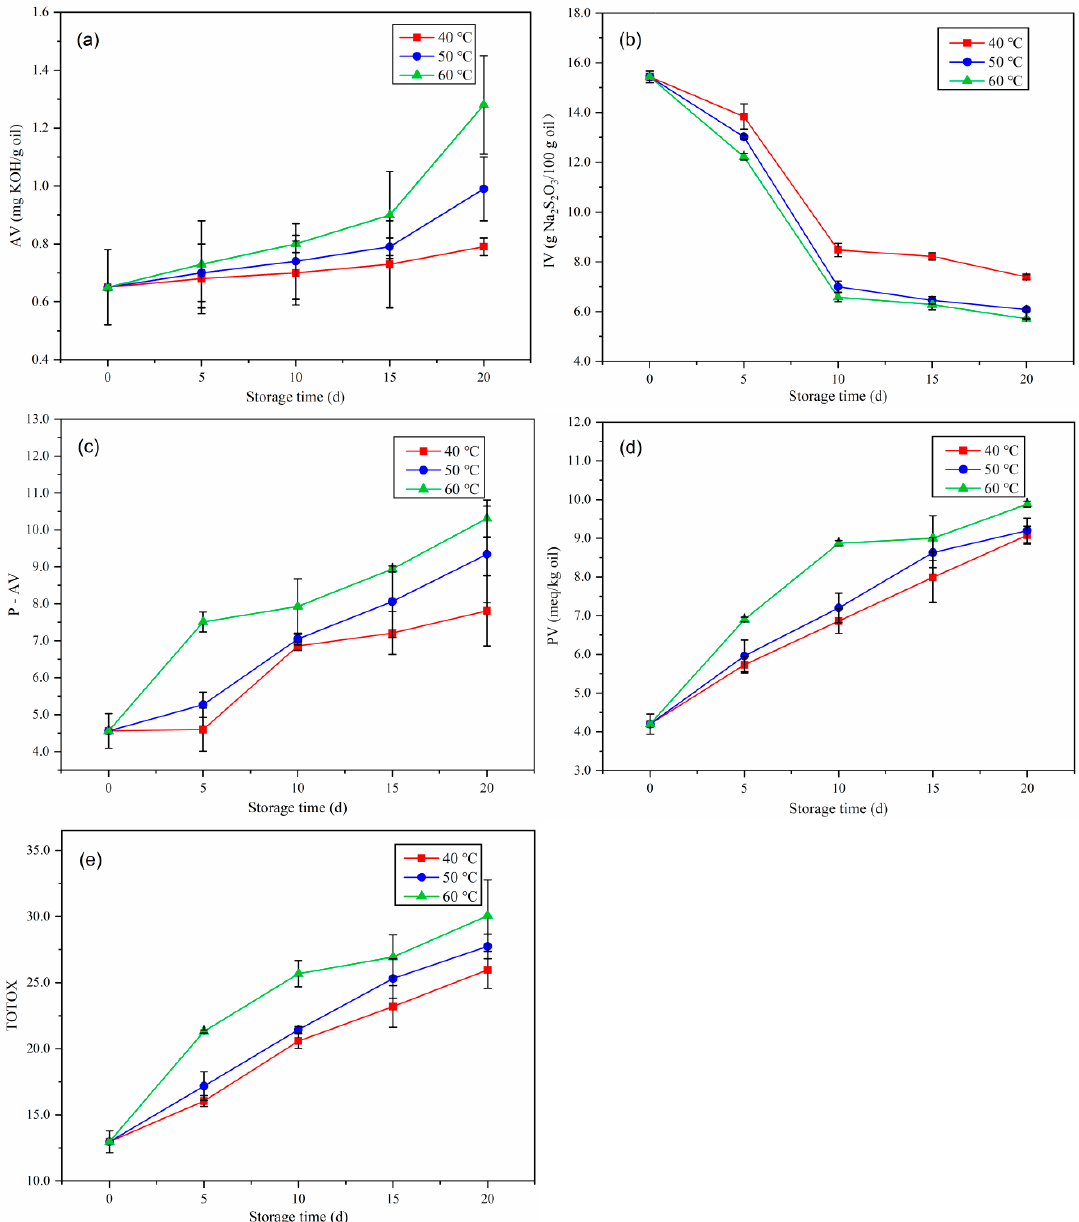
Figure 1. E ff ects of the di ff erent degrees of oxidation of oil on the ( a ) acid value (AV), ( b ) iodine value (IV), ( c ) p -anisidine value (P-AV), ( d ) peroxide value (PV), and ( e ) total oxidation value (TOTOX) of green co ff ee beans during accelerated storage.